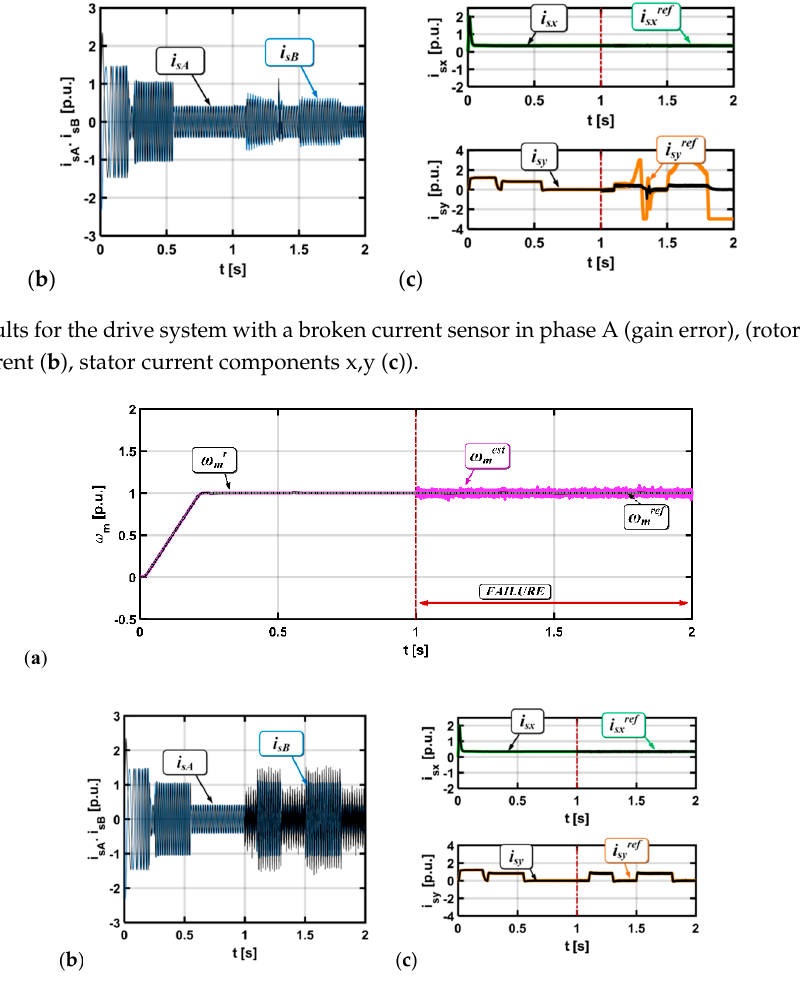
Figure 7. Results for the drive system with a broken current sensor in phase A (white noise), (rotor speed ( a ), stator current ( b ), stator current components x,y ( c )).